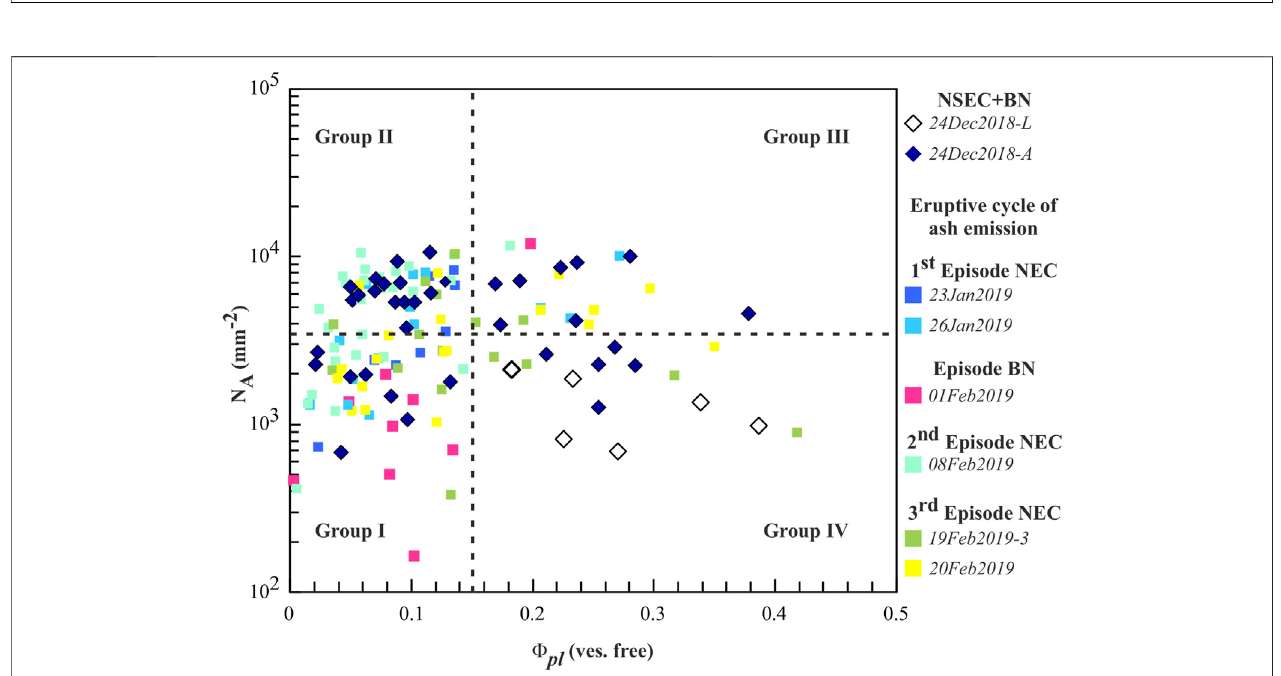
FIGURE9| N A (mm − 2 )vs.plagioclasemicrolitesareafraction(vesiclesfree)plot.Theverticaldashedlineissetat ɸ =15vol.%,whilethehorizontaldashedlineisset a N A = 3,500 mm − 2 , dividing the diagram in four fi elds corresponding to textural Group I ( ɸ < 15 vol.%; N A < 3,500 mm − 2 ), Group II ( ɸ < 15 vol.%; N A > 3,500 mm − 2 ), Group III ( ɸ > 15 vol.%;